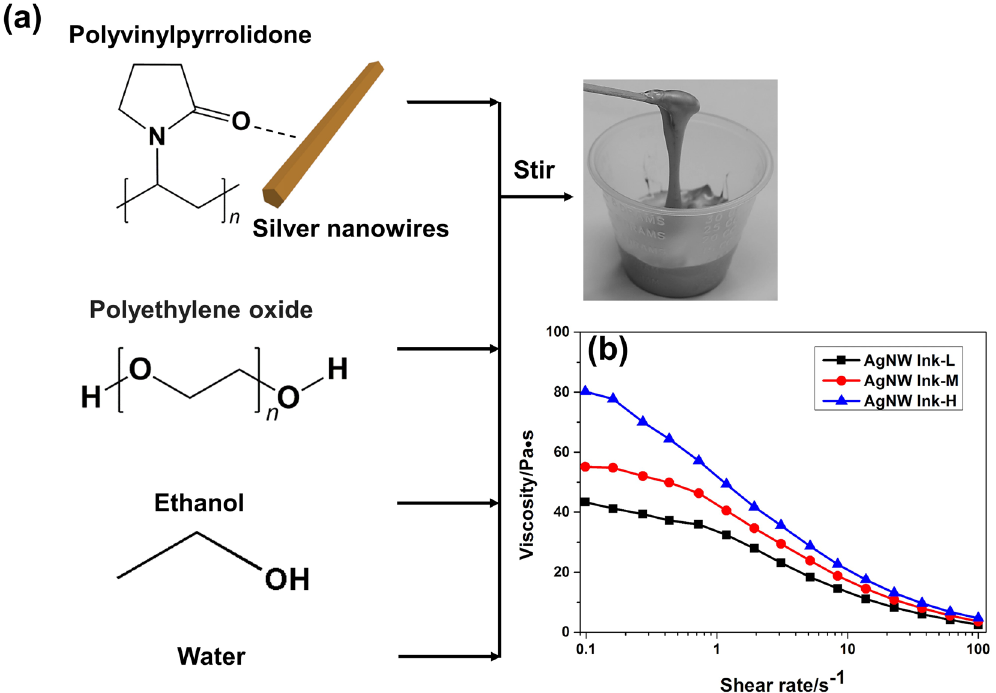
Figure 1. ( a ) Fabrication process of AgNW ink and photograph of the 5 wt% AgNW ink. ( b ) Viscosity as a function of shear rate for different concentration of AgNW